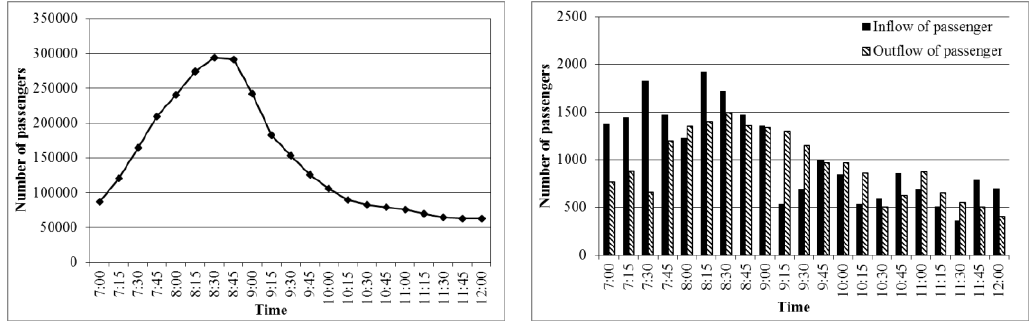
Figure 5. Load passengers of network Figure 6. Inflow and outflow of BJNZ